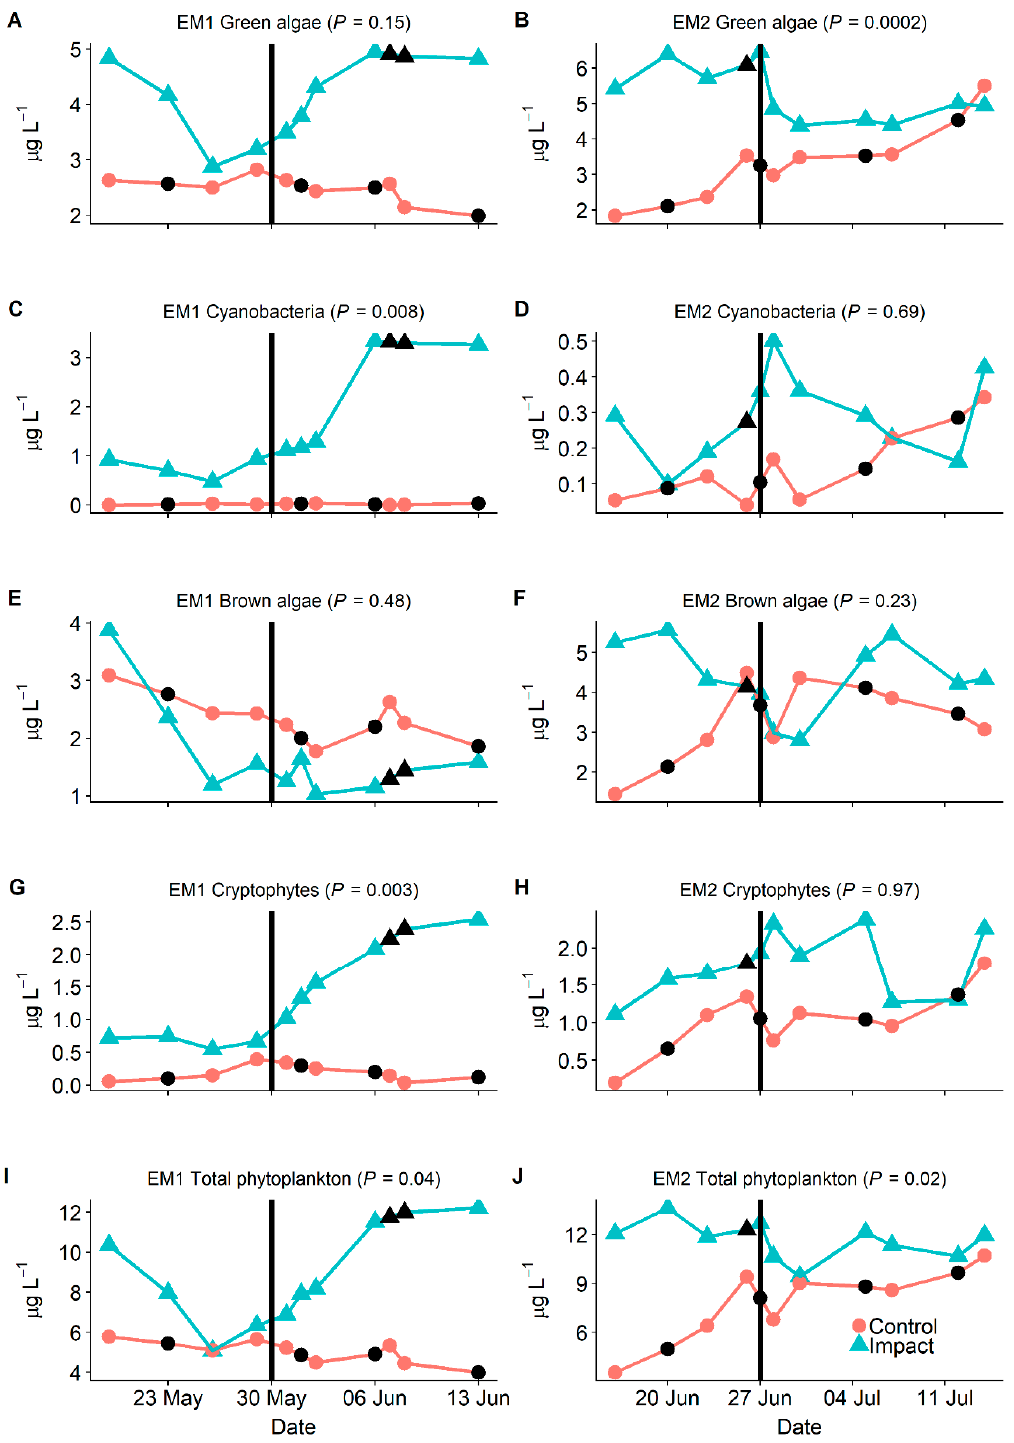
Figure 5. ( A , C , E , G , I ) Mean treatment zone phytoplankton concentrations at the deepest site in both reference Beaverdam (Control, orange lines) and experimental Falling Creek (Impact, blue lines) Reservoirs during the two weeks before and after EM1 and ( B , D , F , H , J ) EM2. p -values are from the Before-After-Control-Impact (BACI) analyses (see Table 1 for all statistics). Black points indicate linearly interpolated values. Mixing events are denoted by vertical black lines. Note y -axis scale differs by plot.